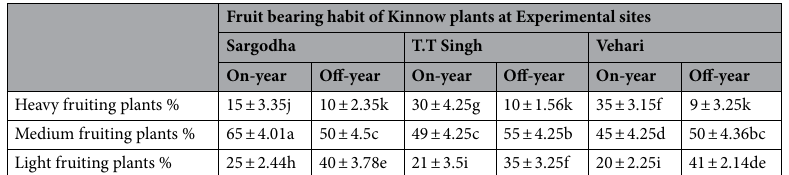
Heavy fruiting plants % Medium fruiting plants % Light fruiting plants Table 4. Fruiting habit of plant of experimental sites during on- & off-years. Results are shown in means (± SD) and sharing different letters are significantly differed to each other according to LSD test (P ≤ 0.05).